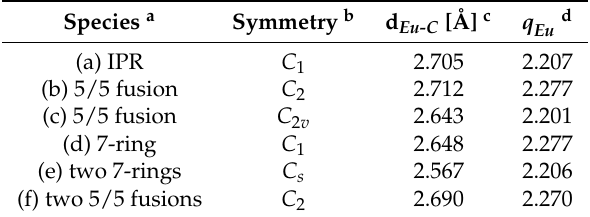
Table 2. The shortest Eu-C contact d Eu − C and metal charge q Eu for the Eu@C 72 isomers. Species